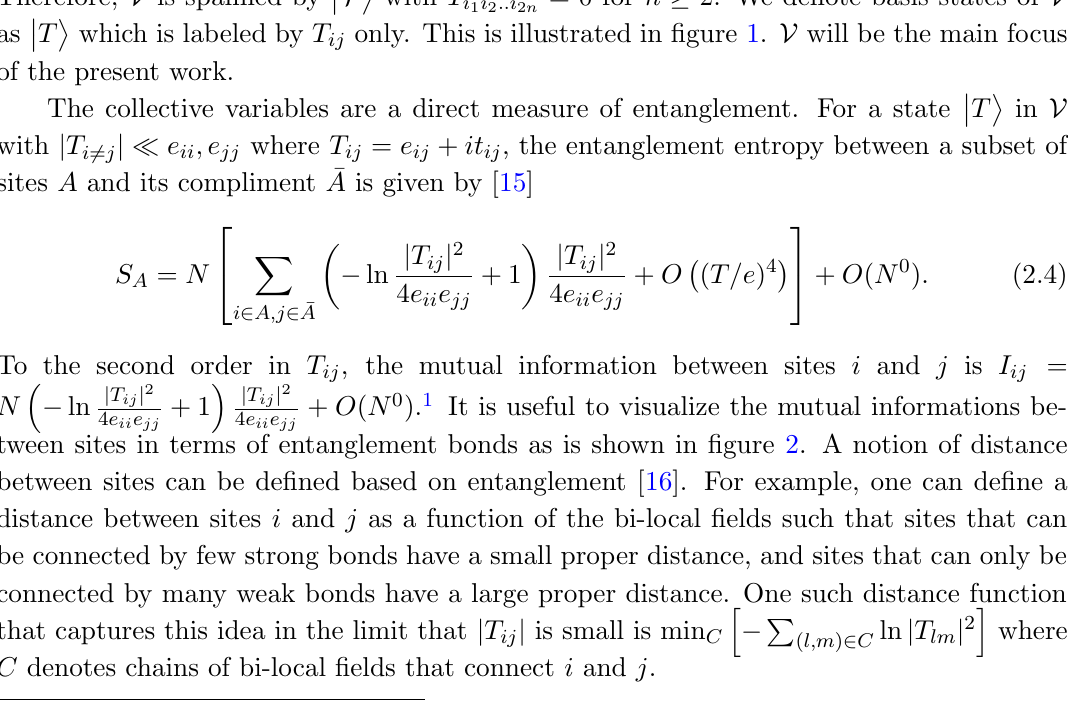
Figure 1 . H is the full Hilbert space of the scalar (cid:12)elds. W is the S N n Z N space of H . V is the O ( N ) invariant sub-Hilbert space of W